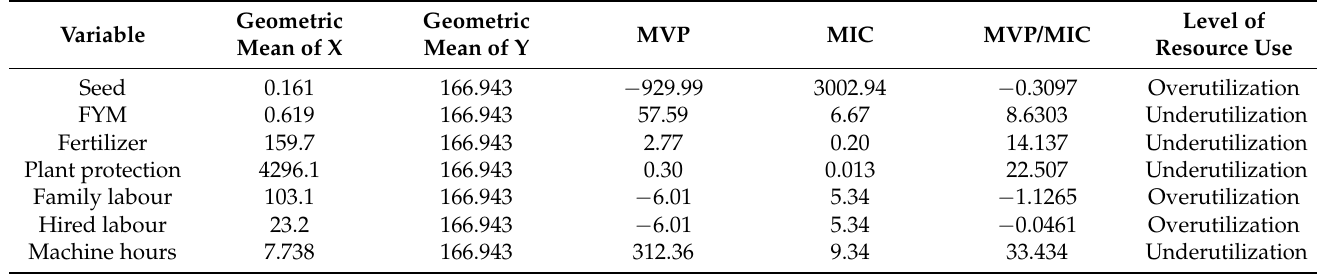
Table 7. Resource use efficiency of marigold cultivation in Jammu Subtropics.